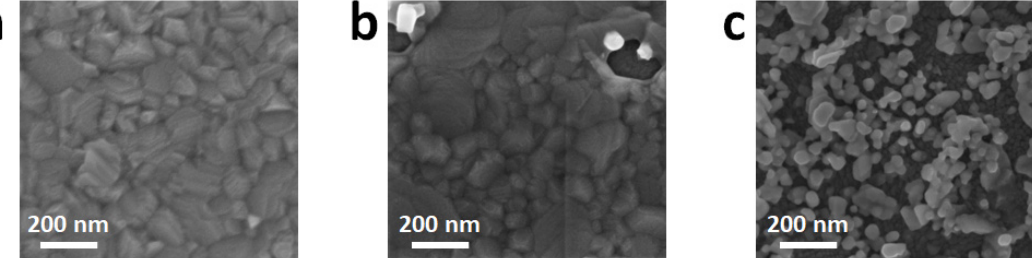
Figure 3. SEM images of as-prepared MAPbBr 3 ( a ), exposed to white light at 10 °C ( b ), and at 60 °C ( c ).